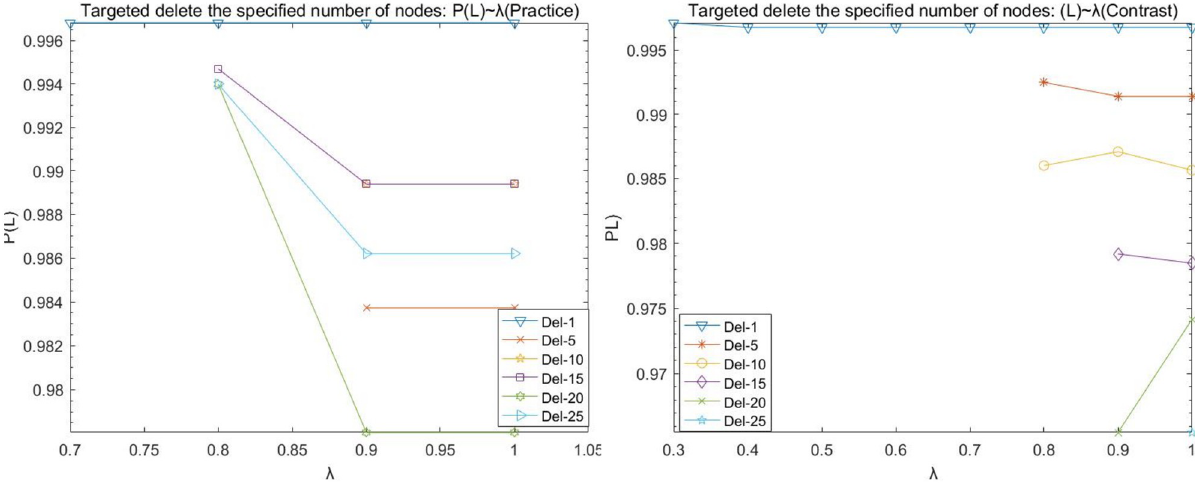
Fig 7. Target disruption- P ( L ) with λ variation